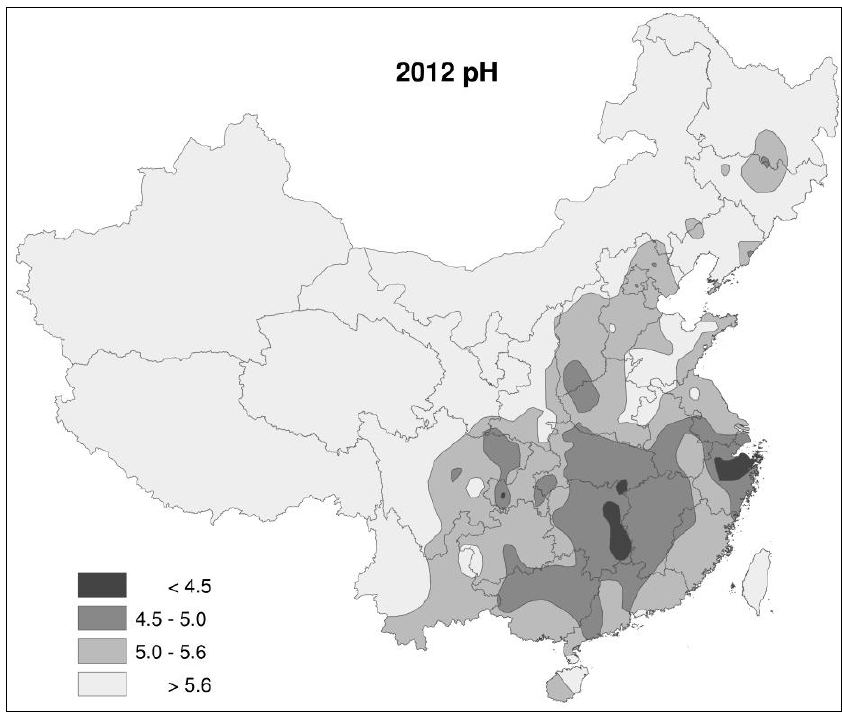
Fig. 10. Annual average pH values of precipitation in China in 2012 (Source: Tang & Wu,